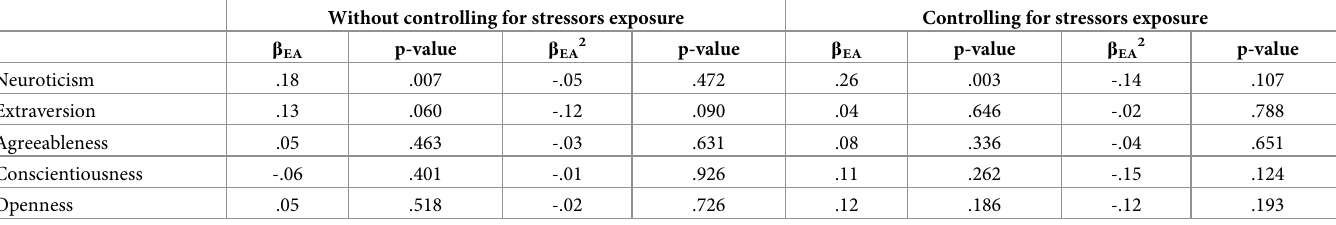
Table 4. Standardized estimates of the linear and quadratic effects of early adversity on personality traits with and without controlling for adulthood stressors exposure in the MIDUS